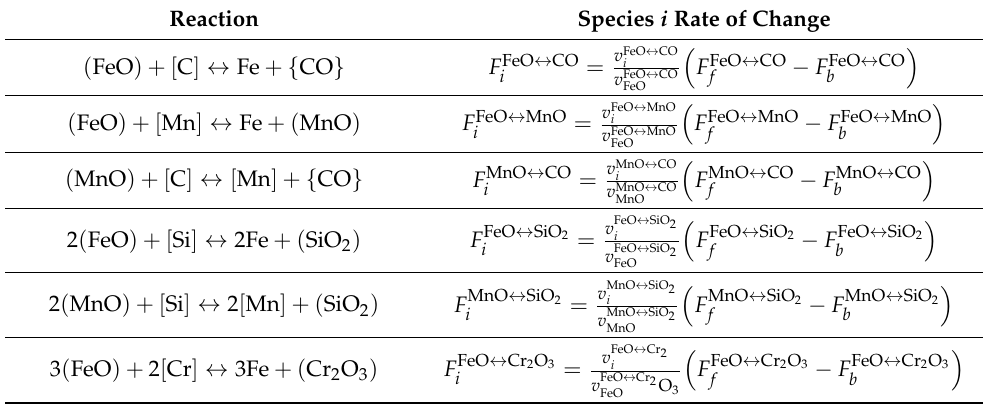
Table A5. Species rates of change for each steel–slag equilibrium reaction.